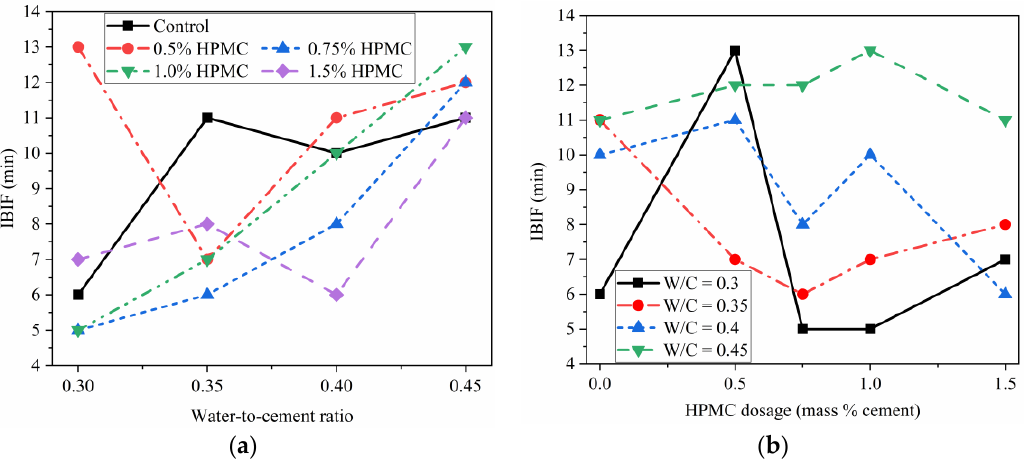
Figure 5. Interval between initial and final setting time (IBIF) of SAC paste with various water-to-cement ratio ( a ) and various HPMC dosages ( b ).